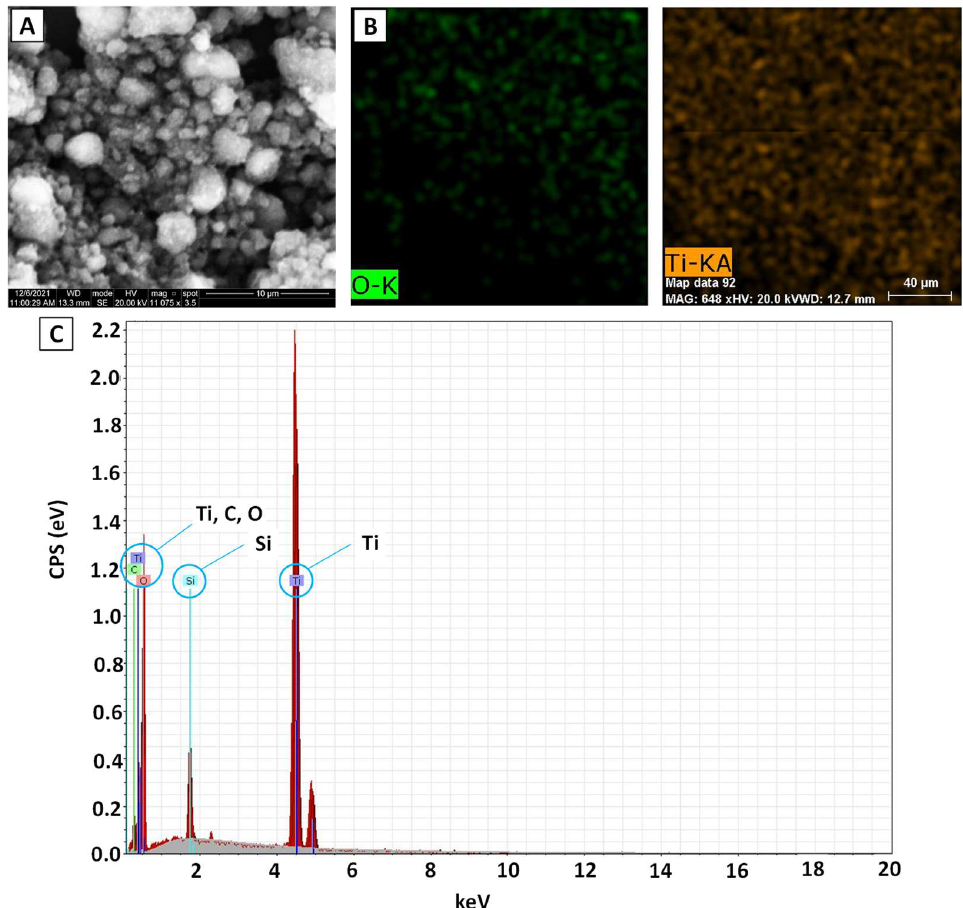
Figure 5. ( A ) SEM image, ( B ) Ti and O particle map, and ( C ) EDX analysis of the TiO 2 NPs.